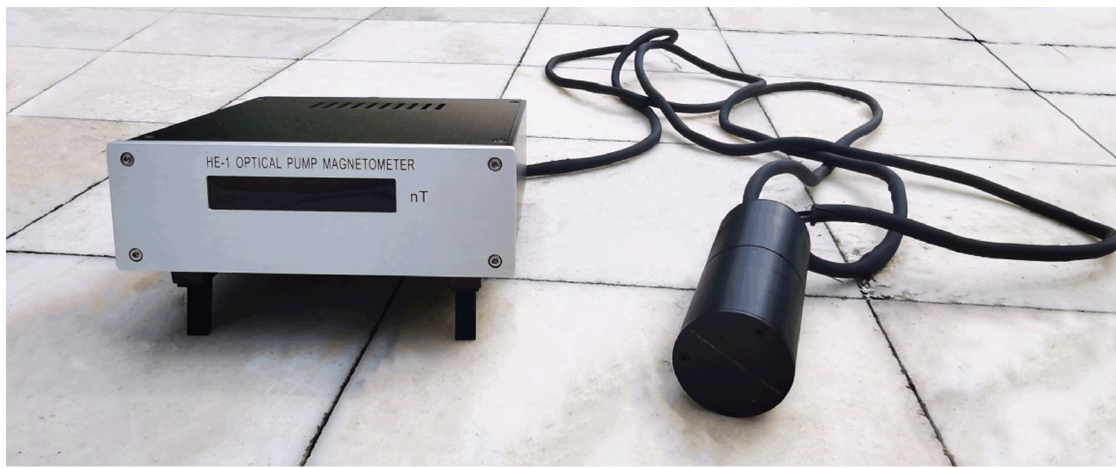
Figure 5. The optical pump magnetometer with high precision.